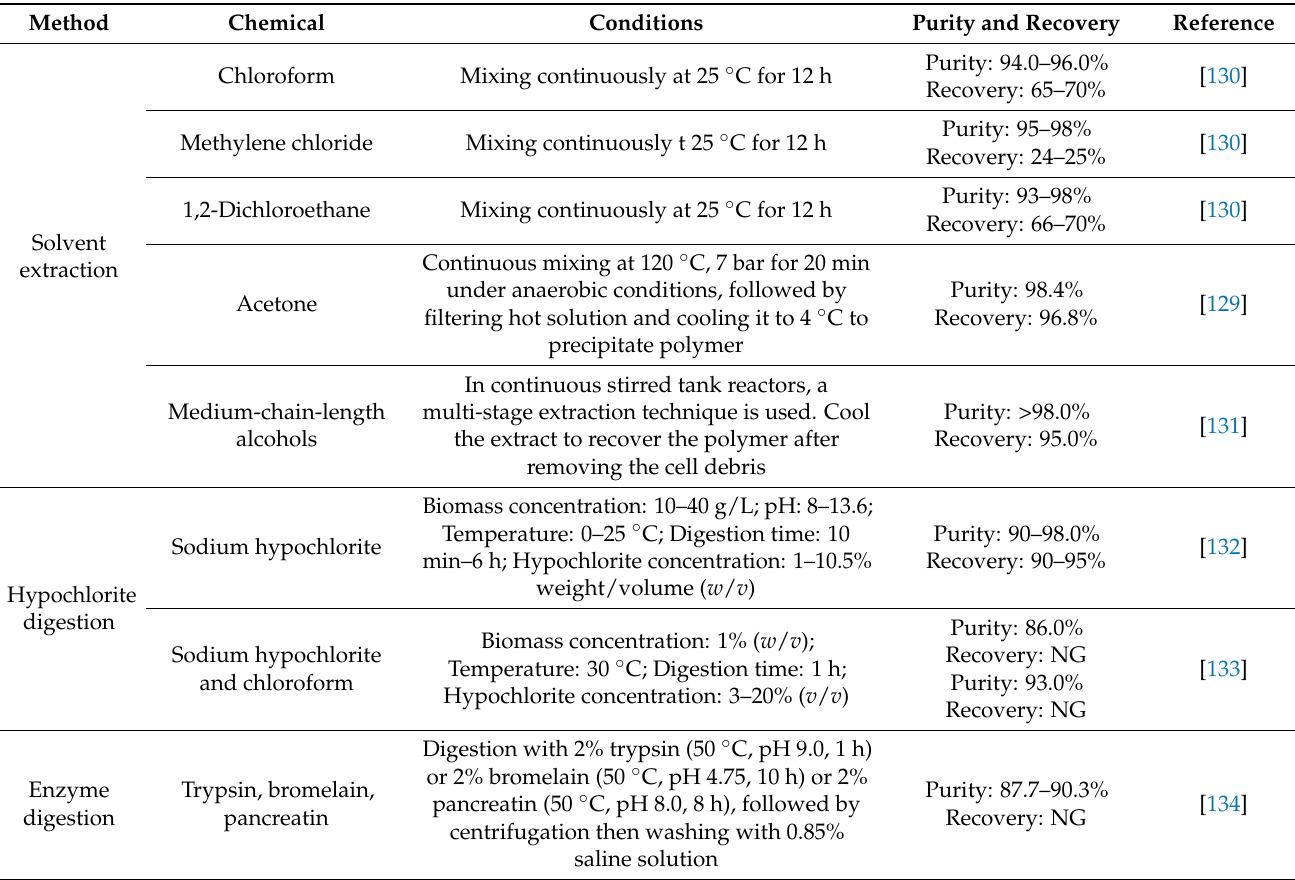
Table 4. PHAs extraction